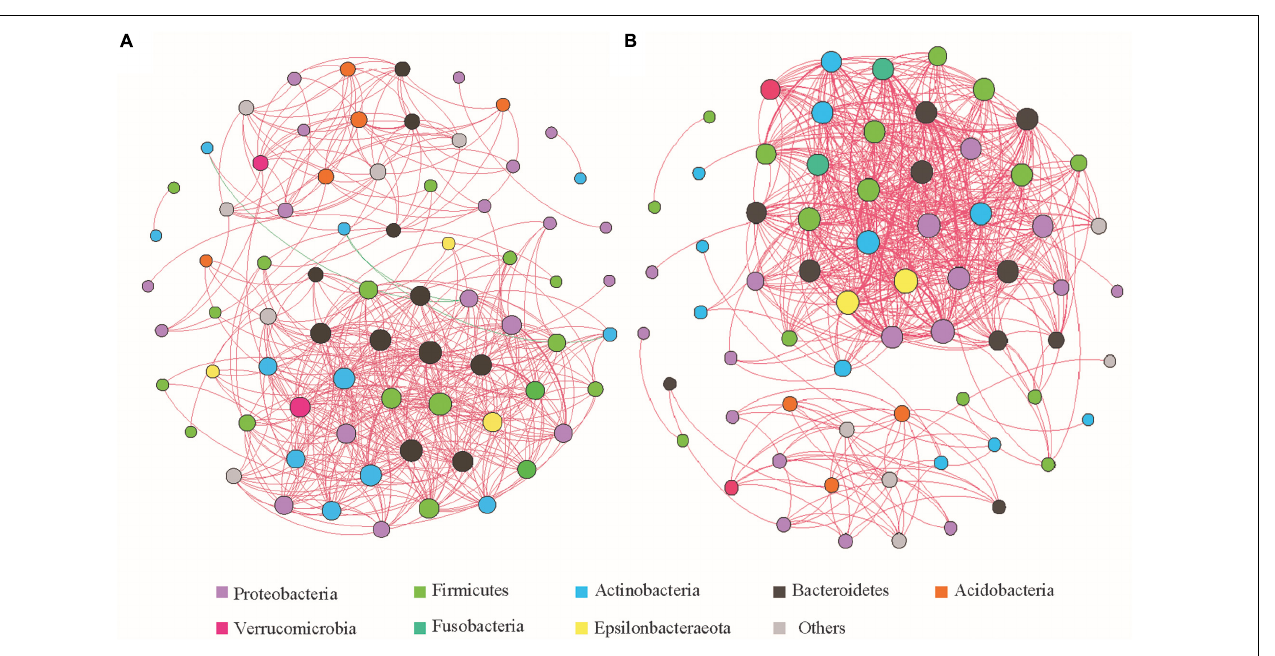
FIGURE 5 | Spearman correlation network analysis of gut microbiota of the common kestrels before and after captivity at the genus level. (A , B) Correlation networks before and after captivity, respectively, with the node size reflecting the number of connections and the color of the node corresponding to the phyla as listed. Red and green lines represent positive and negative correlations, respectively, and the thickness of the line indicates the strength of the